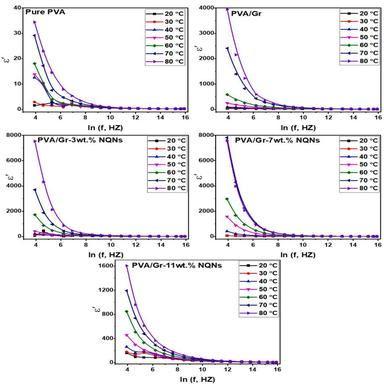
ε′ as a function of ln (f) for the pure PVA and the fabricated PNCs (PVA/Gr, PVA/Gr-3 wt% NQNs, PVA/Gr-7 wt% NQNs, and PVA/Gr-11 wt% NQNs). The measurements were conducted at temperatures (20–80 ◦C) and at different applied frequencies starting from 50 Hz up to 8 MHz.